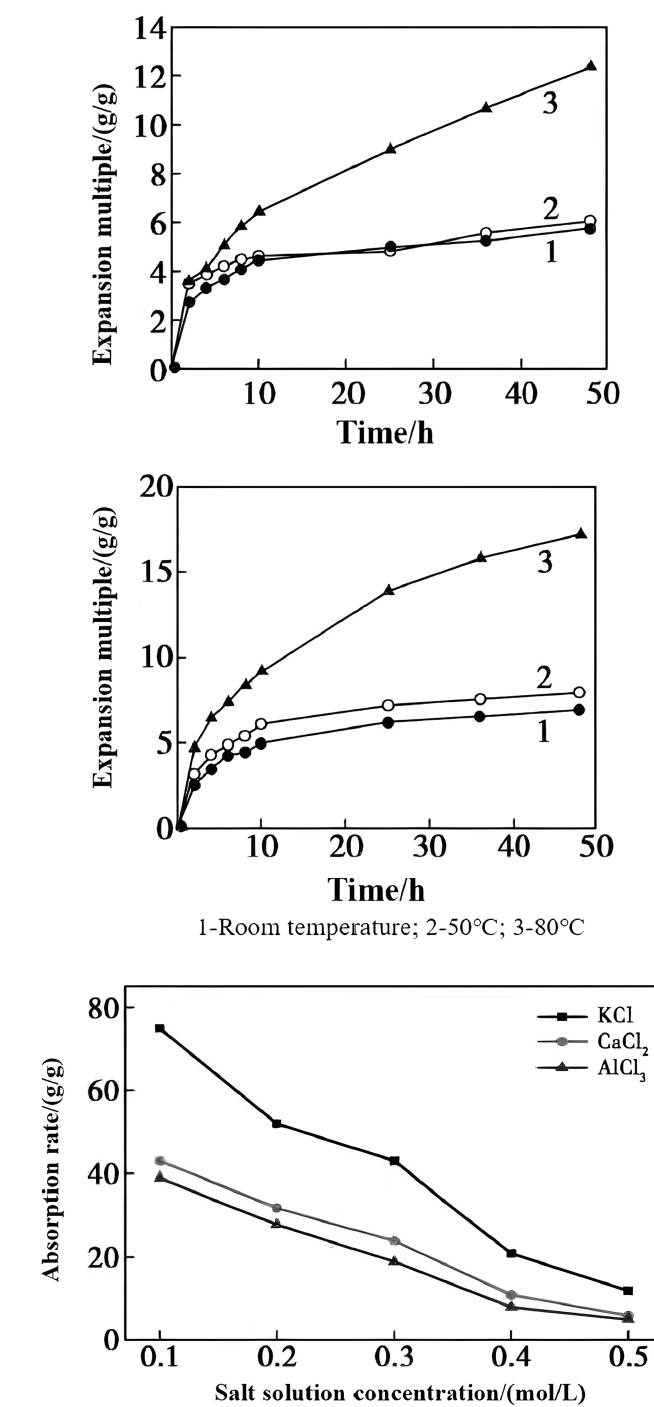
Figure 3. ( A ): ( a ) Trend graph of viscosity at different temperatures, ( b ) effect of different mineral- ization degrees on viscosity, ( c ) viscosity stability curve [76]. ( B ): ( a ) Expansion multiplier curve in ground water, ( b ) expansion multiplier curve in clear water [77]. ( C ) Absorption multiplicity curves in different salt solutions